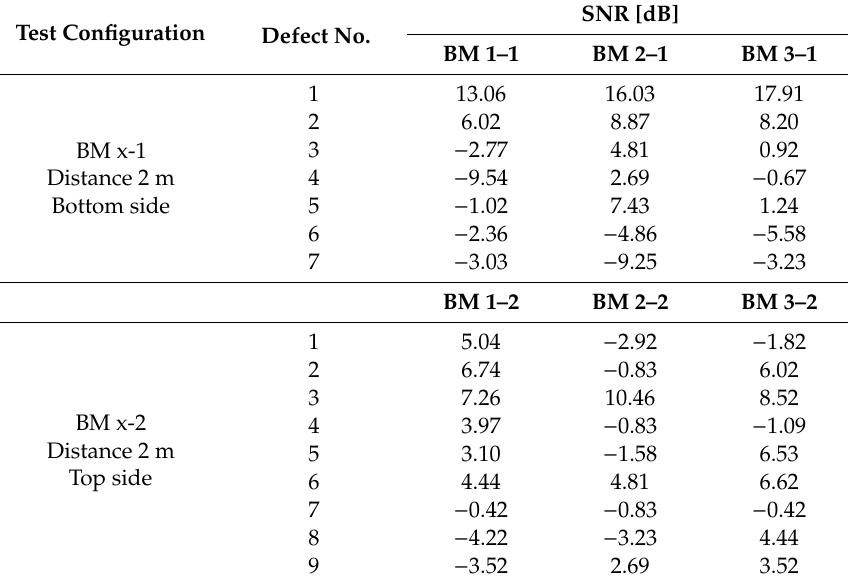
Table 2. SNR values obtained from thermograms presented in Figure 6. Test Configuration Defect